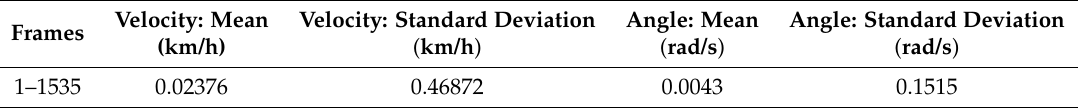
Table 7. FPGA errors after Posterior